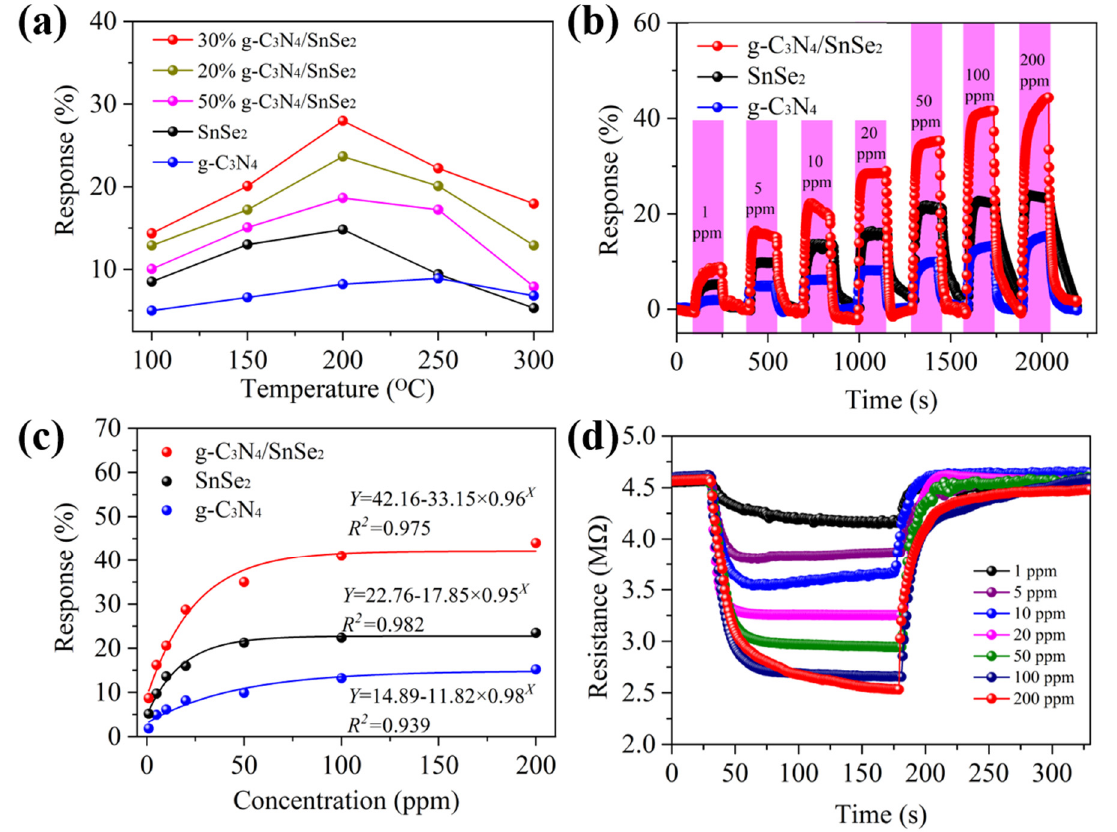
Figure 6. ( a ) Responses of g-C 3 N 4 /SnSe 2 composites with different quality ratios to 20 ppm SO 2 gas at various temperatures. ( b ) Sensing properties of pristine g-C 3 N 4 , SnSe 2 and g-C 3 N 4 /SnSe 2 compo- site sensors at different concentrations of SO 2 gas at 200 °C. ( c ) Response fitting curves of three sen- sors versus SO 2 concentration at 200 °C. ( d ) Typical response–recovery curves for various concen- trations of SO 2 gas at 200 °C.